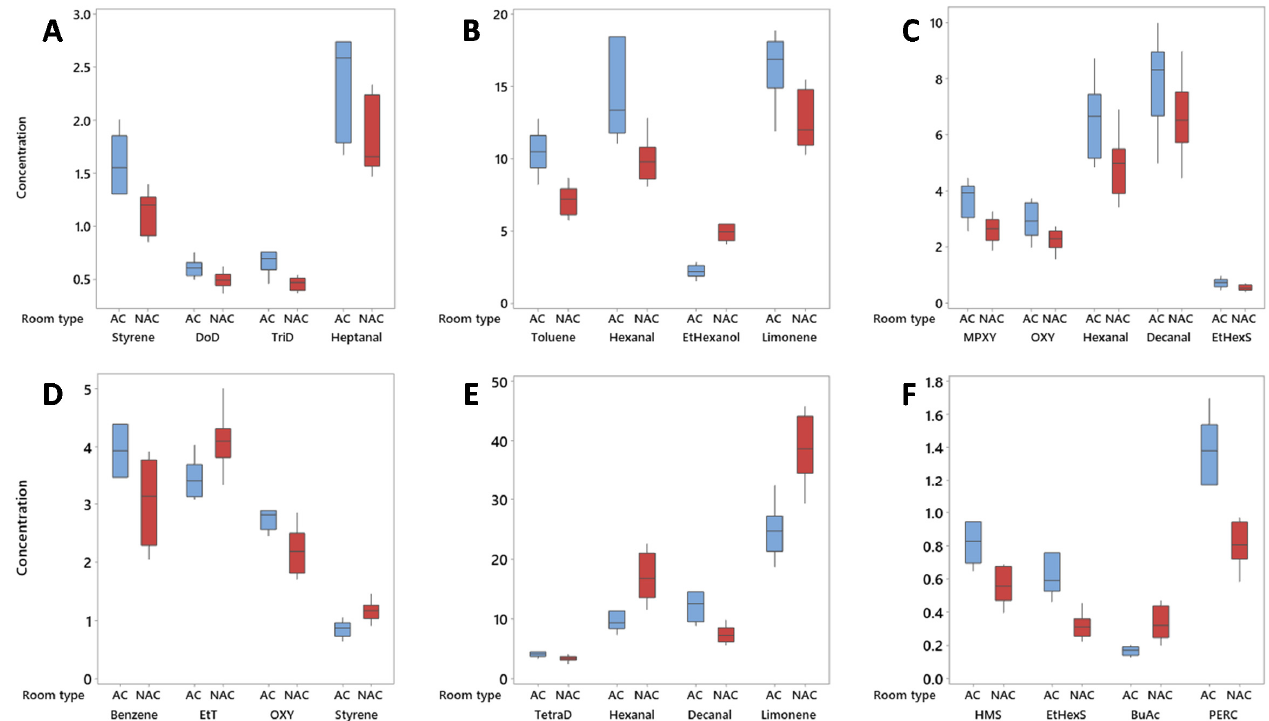
Figure 4. Comparison of VOC concentrations ( μ g/m 3 ) between AC and NAC classrooms. ( A , B ) with n = 6 samples collected in S1, ( C ) with n = 12 samples collected in S3, ( D – F ) with n = 6 and 12 for AC and NAC classrooms in S4, respectively.